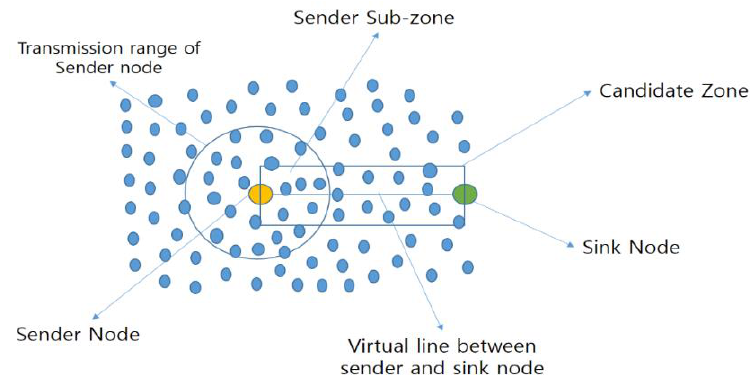
Figure 17. Packet transmission in LORA [16].